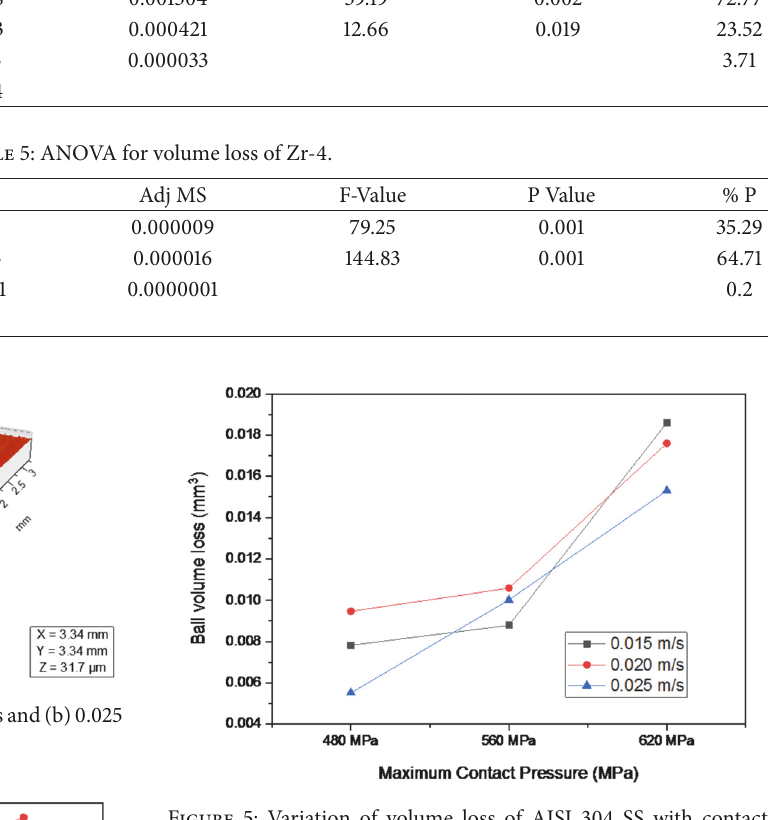
Figure 5: Variation of volume loss of AISI 304 SS with contact pressure and sliding